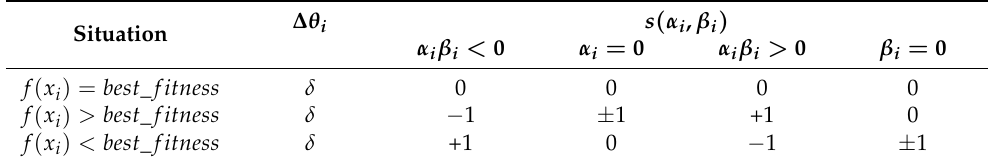
Table 1. Strategies for specifying rotation angle in QRG.